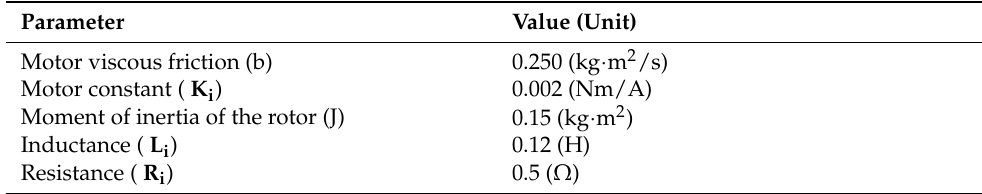
Table 2. The values of the DC motor’s parameters.